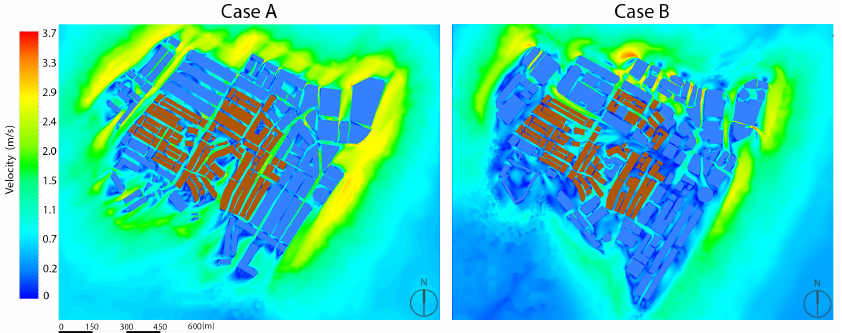
Figure 8. Wind speed contours of Case A ( left ) and Case B ( right ) at the study area (buildings high-lighted as red are the historic shophouses conserved at the Chinatown area).